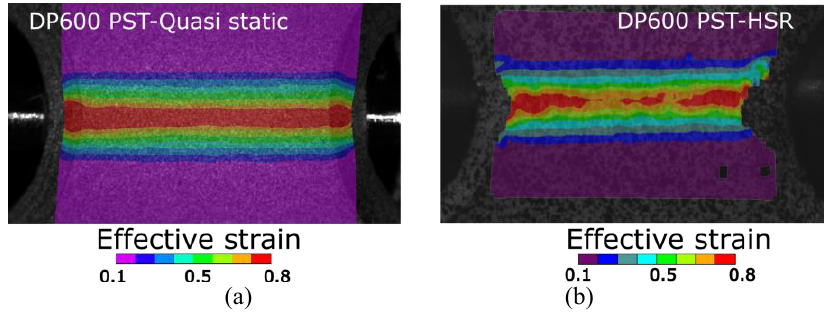
Fig. 6 . Comparison of calculated effective strain fields from quasi-static experiment (a), and high strain rate tests